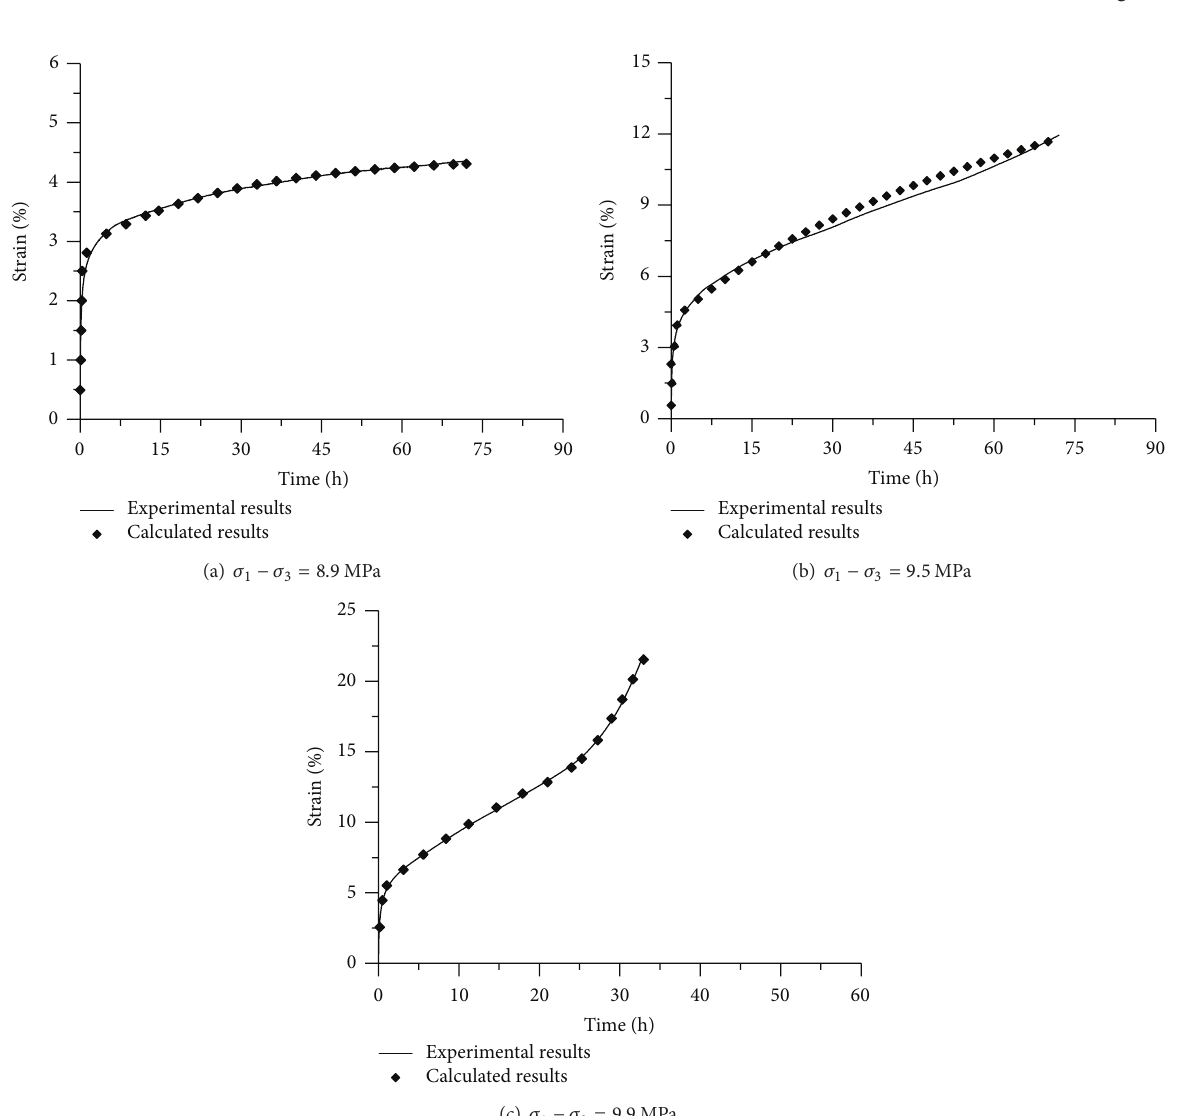
Figure 7: Comparisons of creep strain curves between experimental results and calculated